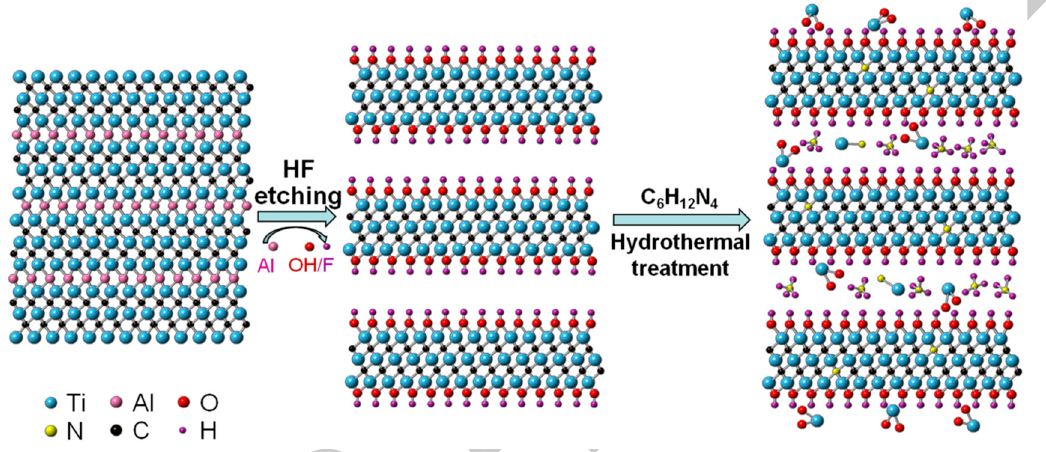
Figure 1. Schematic illustration of the preparation process for N-TiO 2 /TiN/Ti 3 C 2 T x